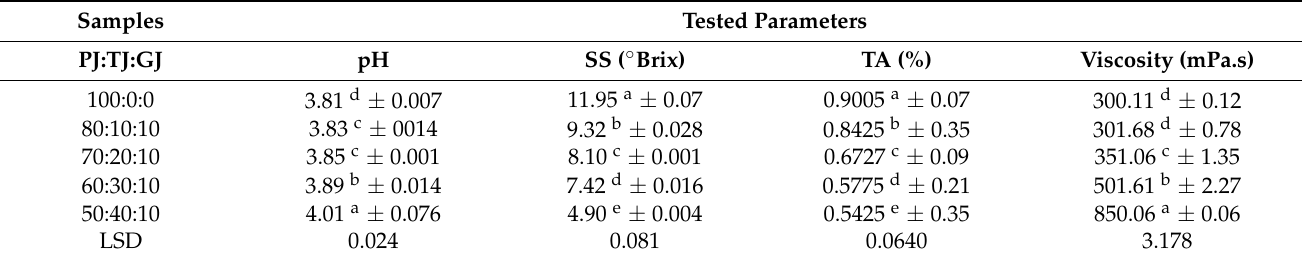
Table 4. Physicochemical variations of Ginger, Pineapple, and Tumeric Juice Mix as influenced by Blends. Samples Tested Parameters